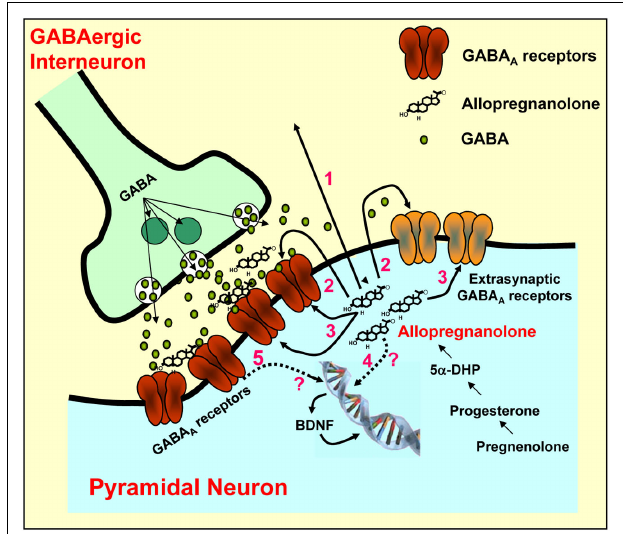
FIGURE 2 |Allopregnanolone biosynthesis and action on GABA A receptors located on synaptic membranes of cortical pyramidal neurons. GABA, after been released from GABAergic interneurons, binds to and activates post-synaptic and extra-synaptic GABA A receptors. Allopregnanolone facilitates the synaptic inhibitory action of GABA at post-synaptic and extra-synaptic GABA A receptors by a paracrine (arrow 1) or autocrine (arrow 2) mechanism or may access GABA A receptors by acting at the intracellular sites (arrow 3) of the GABA A receptors. Finally, allopregnanolone may affect the expression of target genes, including BDNF, directly (arrow 4) or indirectly (arrow 5) by acting at GABA A receptors. BDNF may be released and induce rapid effects at synapses via altering ion channels, or may exert intracellular genomic actions. Modified from Pinna et al.